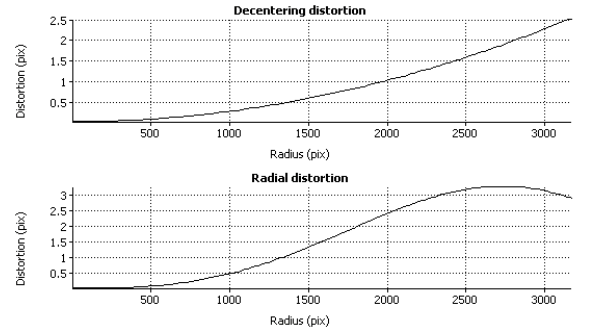
Figure 4. Camera distortion plots for ign8 as obtained from Agisoft Metashape.